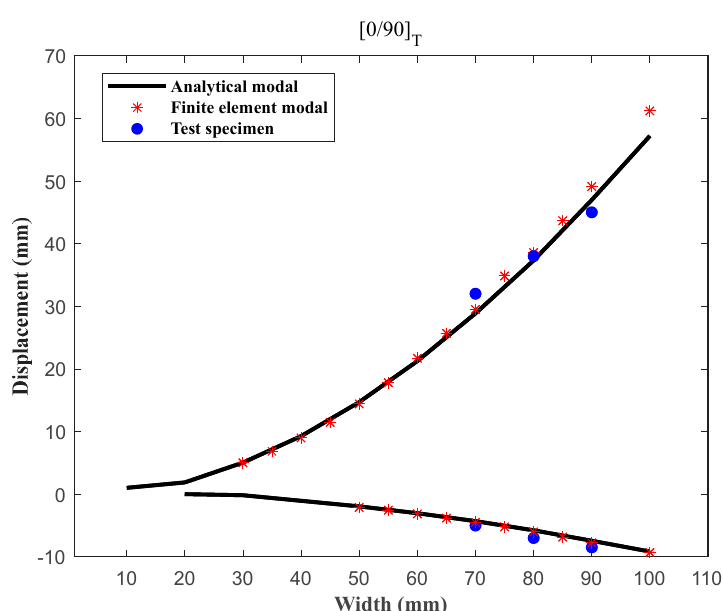
Figure 6. Bifurcation diagram of laminated plates with [0/90] T plies of different sizes.